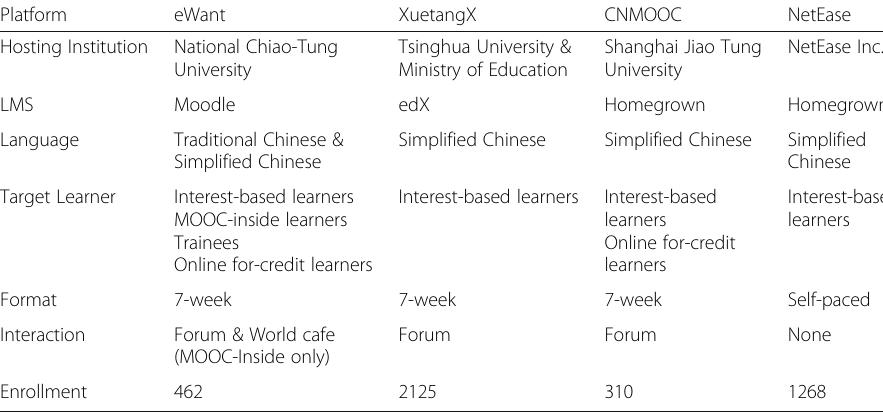
Table 5 The demographics of the first launch of TOL